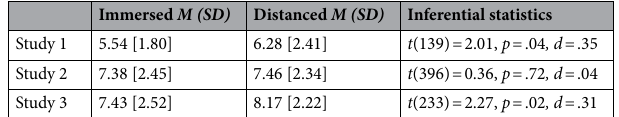
Table 1. Effect of self-distancing on money kept by participants.